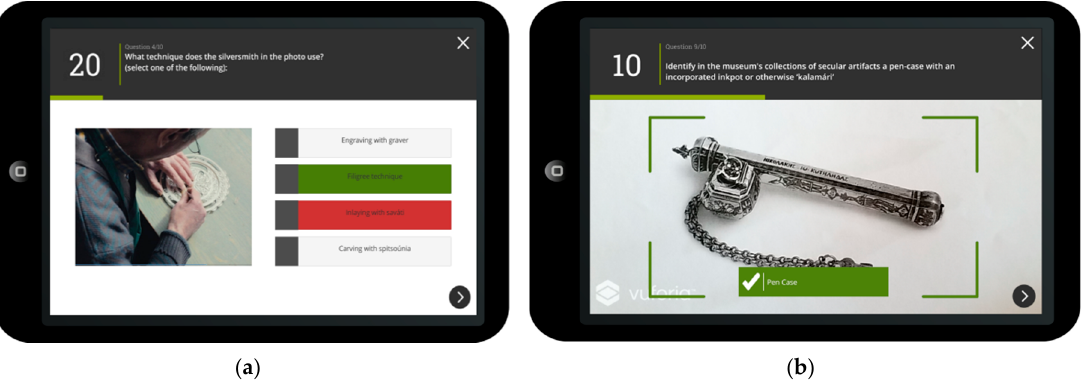
Figure 3. Screenshot of the e-Tracer Augmented Reality (AR) Quiz (user’s view): ( a ) Typical quiz question (multiple choice); ( b ) Augmented Reality question (look and find).